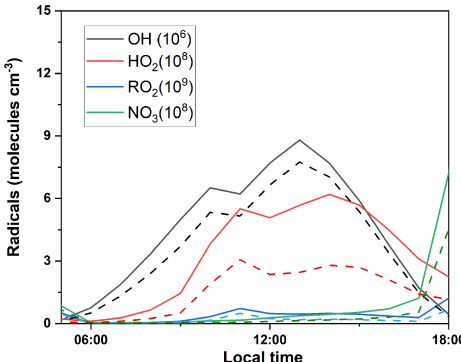
Figure 3. CPF polar plot of O 3 at the DSL station. Figure 4. Simulated average daytime variation of OH, HO